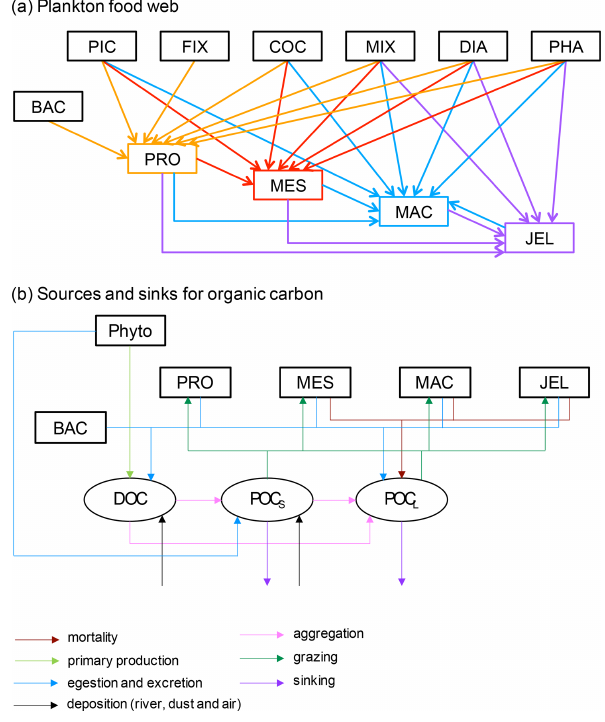
Figure 1. Schematic representation of the PlankTOM11 marine ecosystem model (see Table 1 for PFT definitions). (a) The plankton food web; arrows represent the grazing fluxes by protozooplankton (orange), mesozooplankton (red), macrozooplankton (blue) and jel- lyfish zooplankton (purple). Only fluxes with relative preferences above 0.1 are shown (see Table 3). (b) Source and sinks for dis- solved organic carbon (DOC) and small (POC S ) and large (POC L ) particulate organic